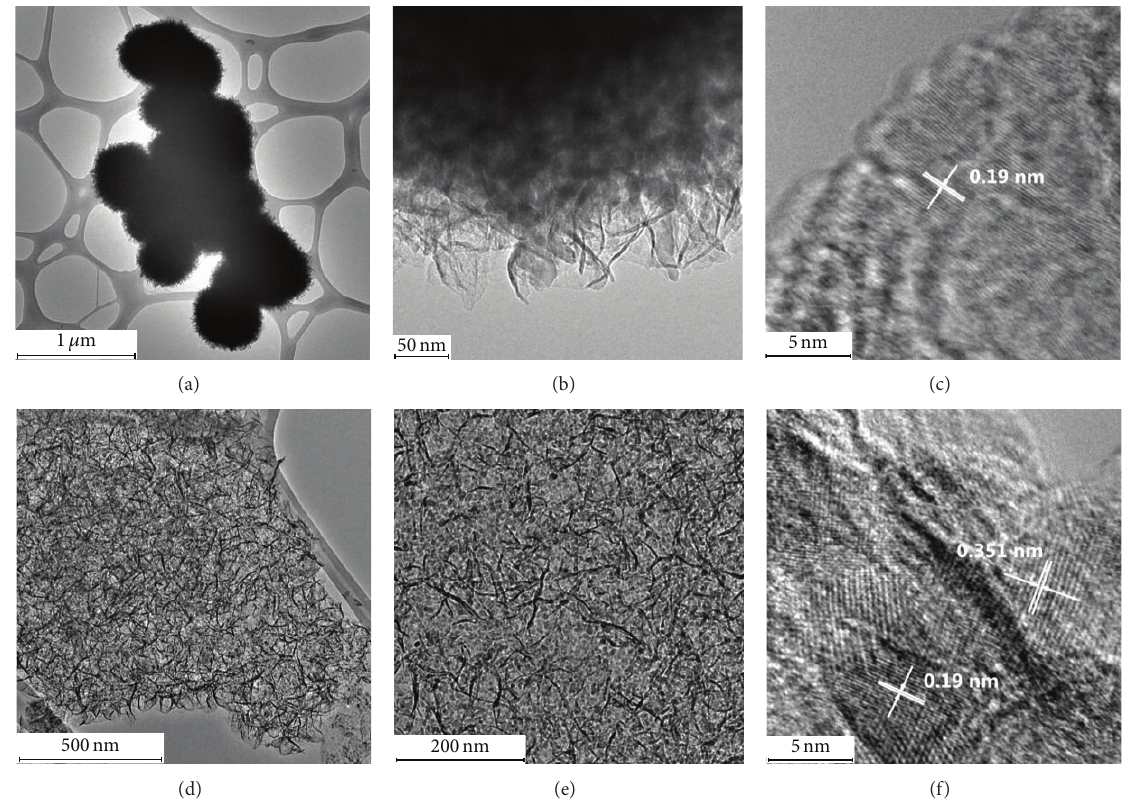
Figure 4: ((a), (b)) Low magnification TEM images of TiO 2 and (c) high magnification TEM image of the edge of a TiO 2 nanosheet. ((d), (e)) Low magnification TEM image of the RGO-TiO 2 composite and (f) high magnification TEM image of the surface of the